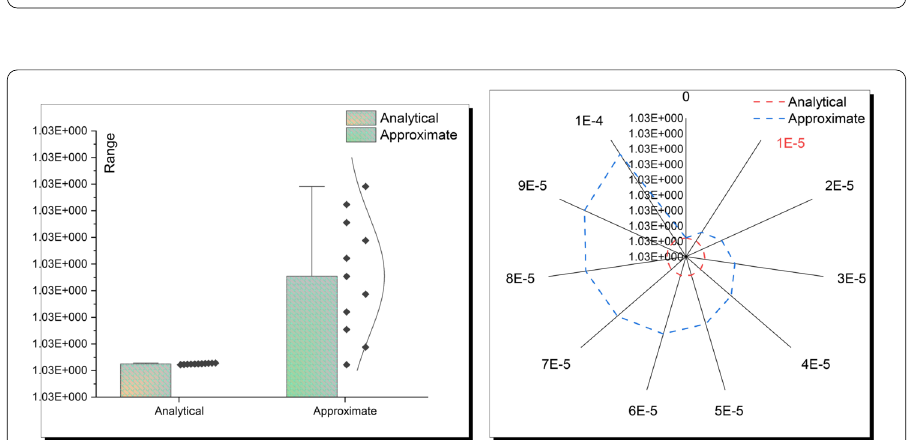
Figure 4 Two-dimensional sketches between the analytical and approximate solutions based on the ECBS method for illustrating the matching between solutions